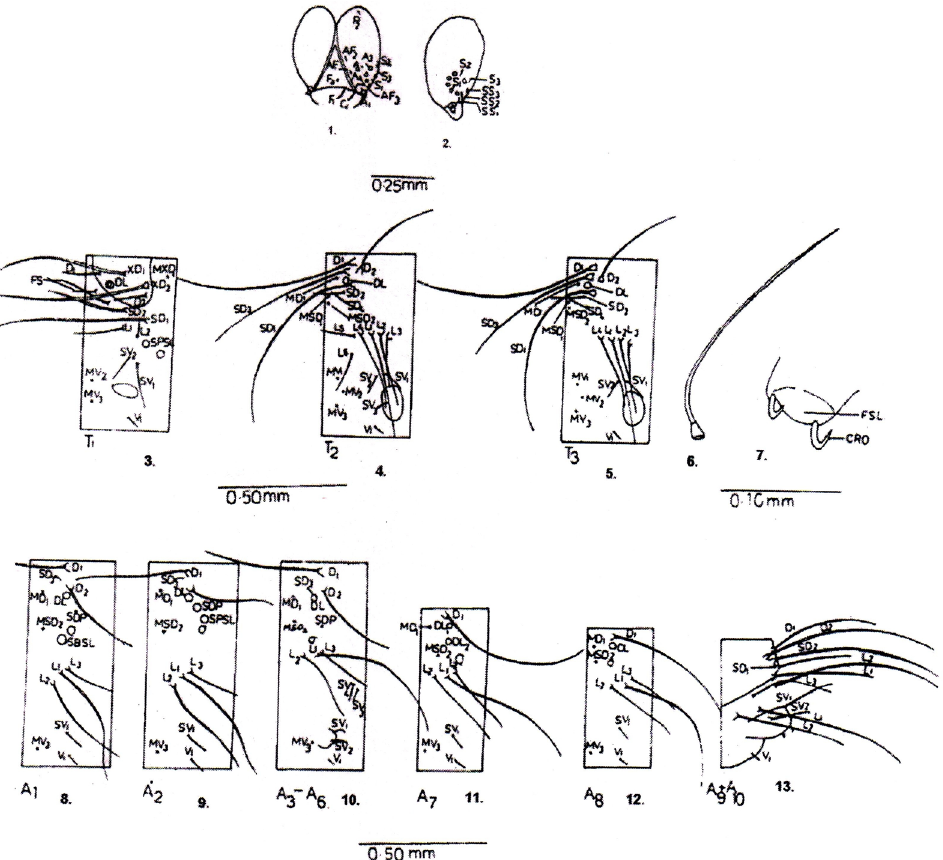
Figure 1. First instar larva of Castalius rosimon (Fabricius) 1 - Chaetotaxy of head (frontal view); 2 - Chaetotaxy of head (lateral view); 3 - Chaetotaxy map of T 1; 4 - Chaetotaxy map of T 2; 5 - Chaetotaxy map of T 3; 6 - Tactile seta of dorsal group; 7 - Proleg of A 3; 8 - Chaetotaxy map of A 1; 9 - Chaetotaxy map of A 2; 10 - Chaetotaxy map of A 3 to A 6; 11 - Chaetotaxy map of A 7; 12 - Chaetotaxy map of A 8; 13 - Chaetotaxy map of A 9 + A